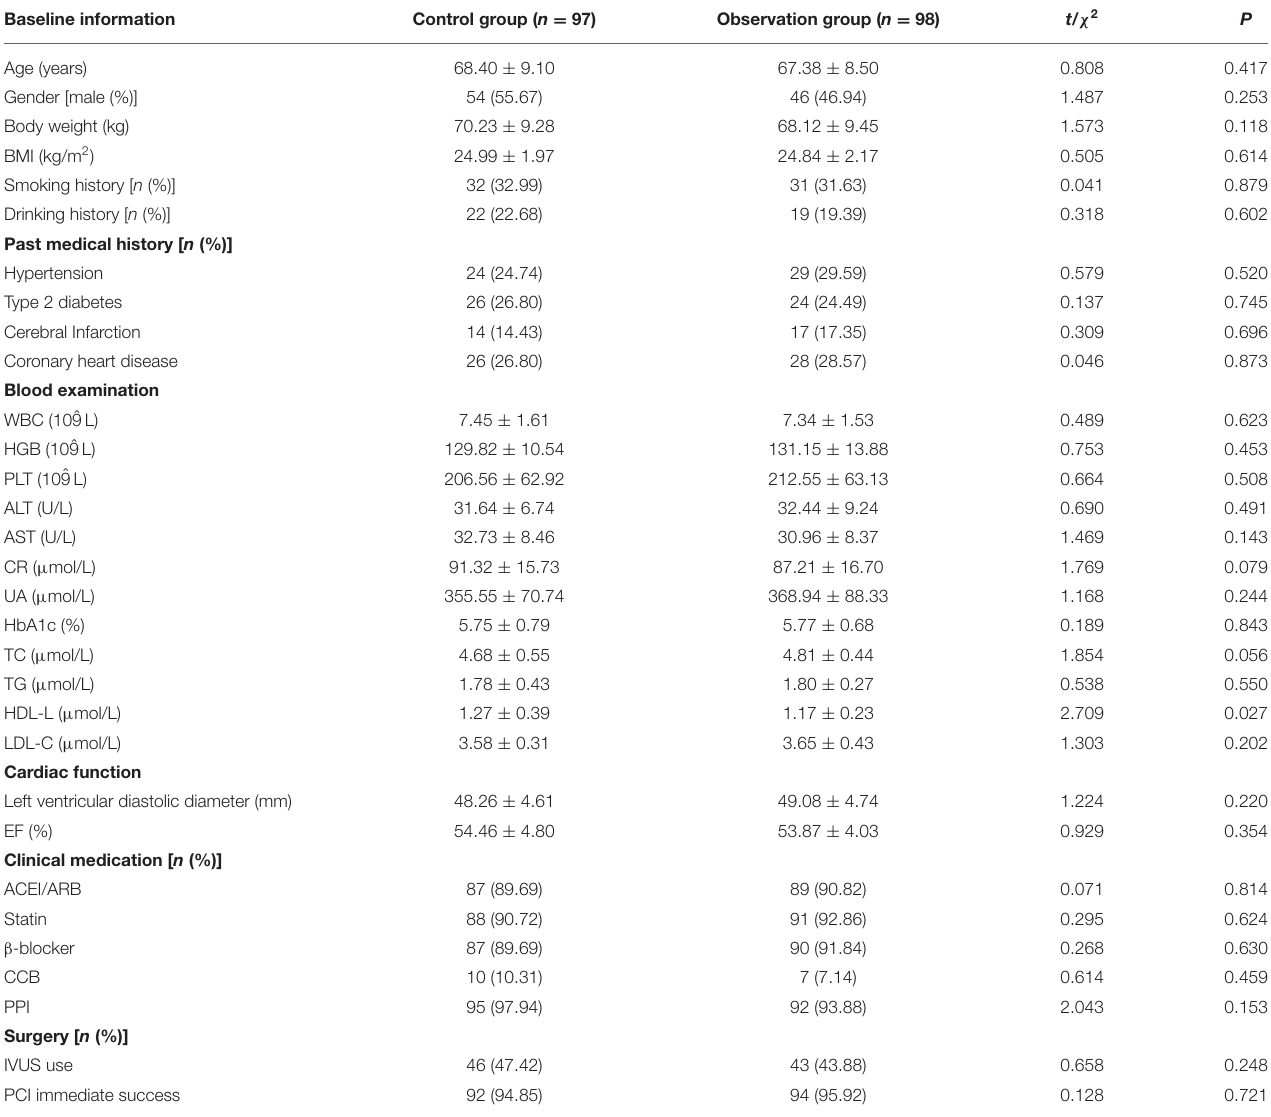
TABLE 1 | Comparison of baseline data between the two groups. Baseline